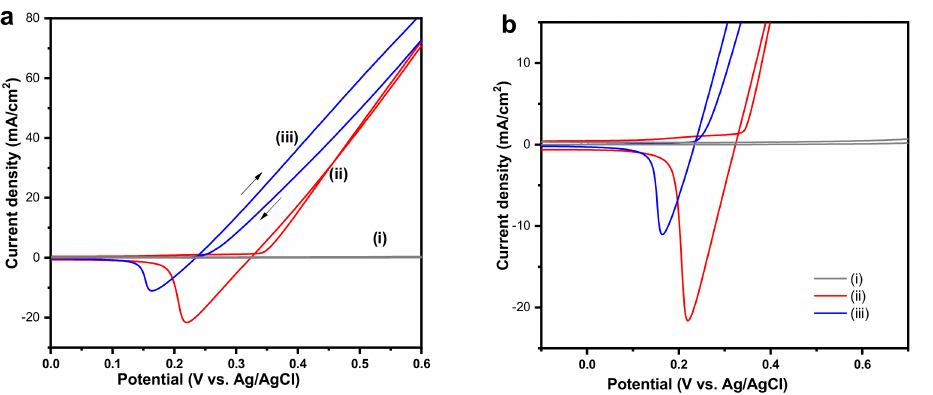
Figure 6. ( a ) CVs at 50 mV/s for bare-CP (i), and Ni(OH) 2 -DMSO/CP electrodes (ii) prepared under DMSO solution in 0.33 M urea and 1.0 M KOH; Ni(OH) 2 -DMSO/CP electrodes in 0.33 M urea and 5.0 M KOH (iii), ( b ) displays an enlarged